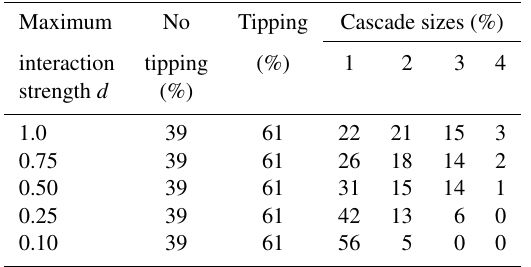
Table 3. Share of tipping events in ensemble simulations. For differ- ent maximum values of the interaction strength d (first column), the share of ensemble simulations is shown that have a tipping event or cascade (third column) within the Paris limit until the global mean surface temperature increase reaches 2.0 ◦ C above pre-industrial. This means that 61% of all ensemble members contain a tipping event or cascade, whereas 39% do not (second column) if all inter- action strengths until 1.0 are considered (see Fig. 5a and b). Overall, the fraction of tipping events stays the same and does not decrease for lower maximum interaction strengths. However, the distribution of tipping events and cascade sizes changes, i.e. the number of large cascades decreases with lower maximal interaction strength. This is shown in the split last column that displays the share of cascades with one, two, three or four